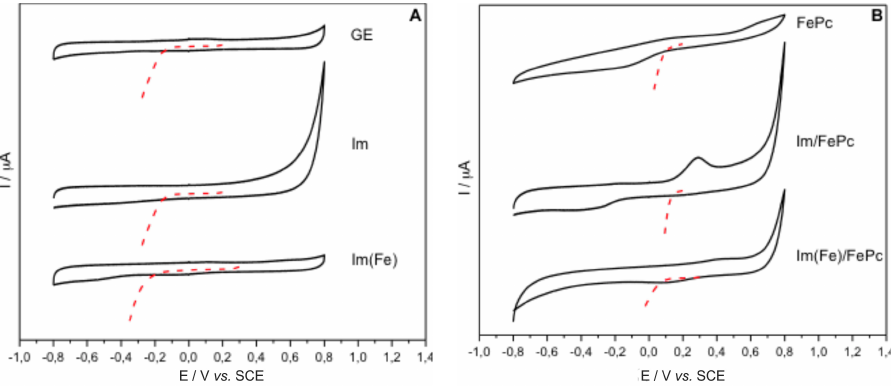
Figure 4. ( A ) Cyclic voltammetry and polarization curves for the oxygen reduction reaction (ORR) (O 2 saturated conditions, dotted red line) of the graphite electrodes (GE) and GE modified with Im and with Im(Fe); ( B ) Cyclic voltammetry and polarization curves (O 2 saturated conditions, dotted red line) of the GE modified with FePc, Im-FePc and Im(Fe)-FePc. SCE, saturated calomel electrode.